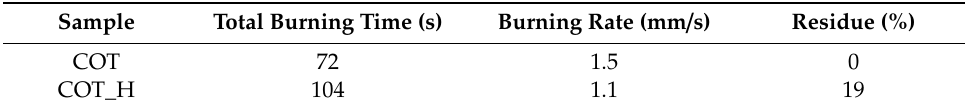
Table 7. Results from horizontal flame spread tests for untreated (COT) and hydrophobin-treated (COT-H) cotton